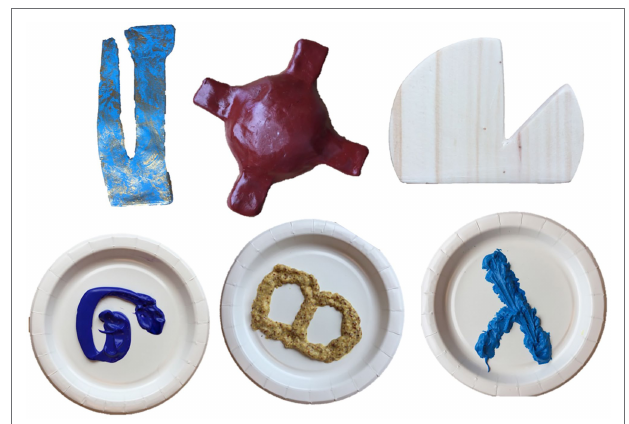
FIGURE 1 | Novel solid object exemplars (top row) and nonsolid substance exemplars (bottom row) used in the free-play, recognition, and generalization tasks. Clockwise from top left, the objects’ names and materials are sebby (textured clay), tulver (clay), blicket (wood), bosa (icing), teema (seed style Dijon mustard), and modi (dyed mayonnaise).